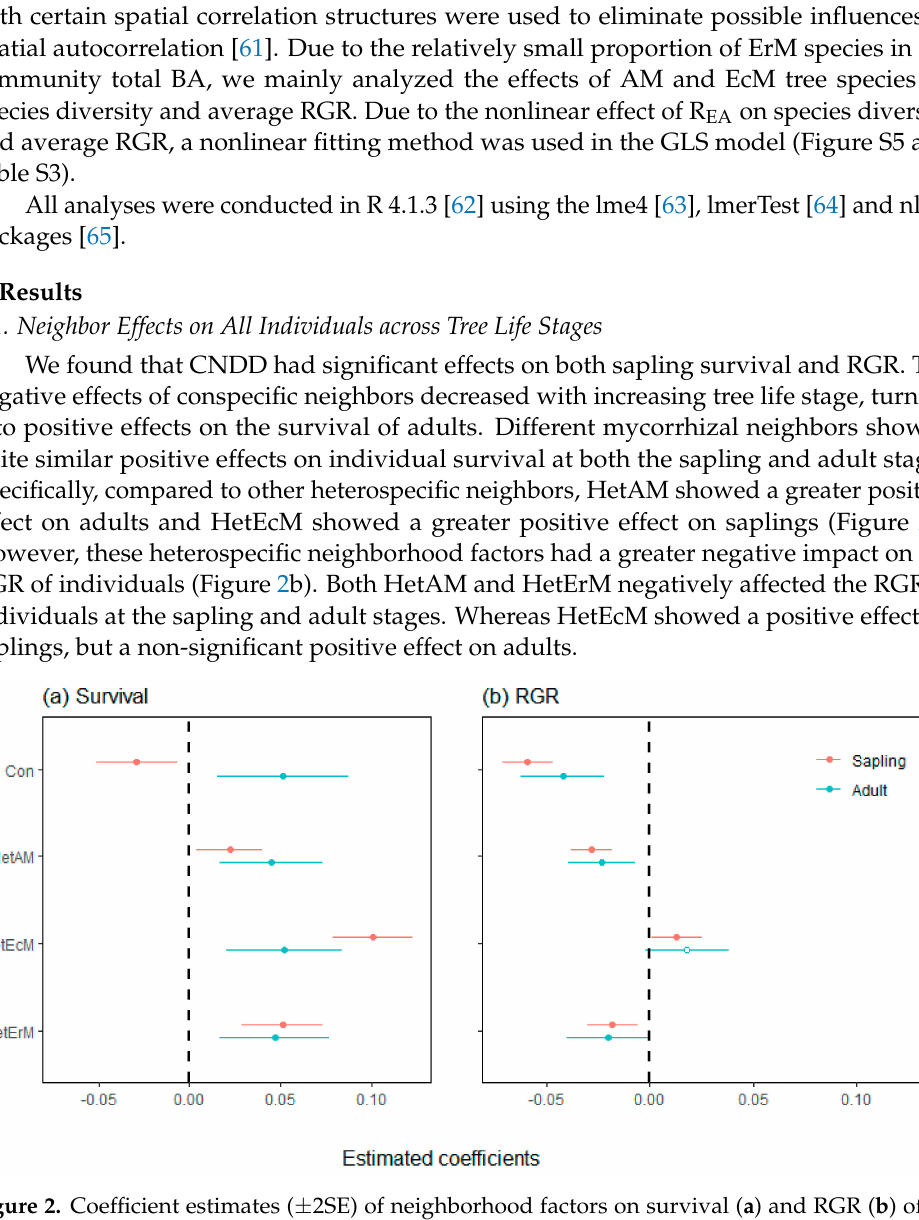
Figure 2. Coefficient estimates ( ± 2SE) of neighborhood factors on survival ( a ) and RGR ( b ) of all individuals at the sapling and adult tree life stages. Solid circles indicate significant effects ( p < 0.05), while open circles indicate non-significant effects. RGR, relative growth rates; Con, conspecific density; HetAM, heterospecific AM density; HetEcM, heterospecific EcM density; HetErM, heterospecific ErM